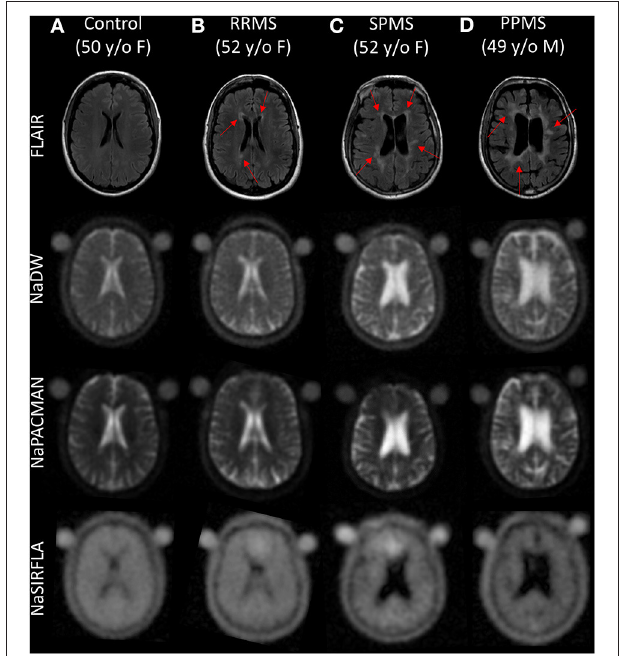
FIGURE 1 | Qualitative axial image comparison of (A) a healthy control and (B–D) three MS subtypes for FLAIR, NaDW, NaPACMAN, and NaSIRFLA. Regions of hyperintensity on FLAIR (red arrows) have visibly greater sodium signal compared to NAWM on NaDW and NaPACMAN (hyperintense), where NaPACMAN shows the greatest lesion contrast. Lesion sodium intensity on NaSIRFLA is difficult to visually distinguish from NAWM, but is slightly hypointense. Note that NaSIRFLA images display an artifact of hyperintensity in the frontal sinus cavity region due to off-resonance effects.